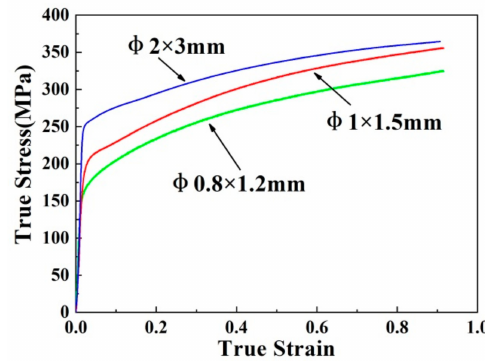
Figure 5. Flow stress of compressed samples with various geometry sizes.